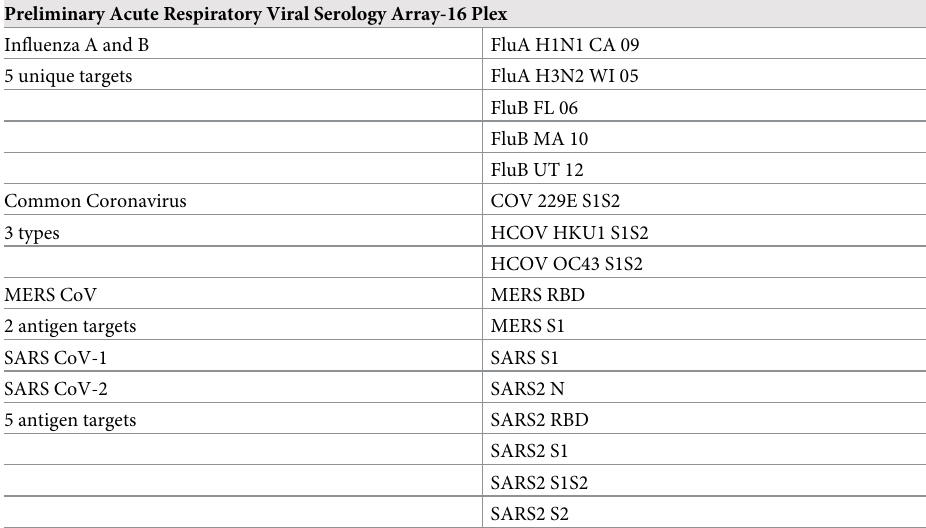
Table 1. Antigens on an early 16-plex ARVA.